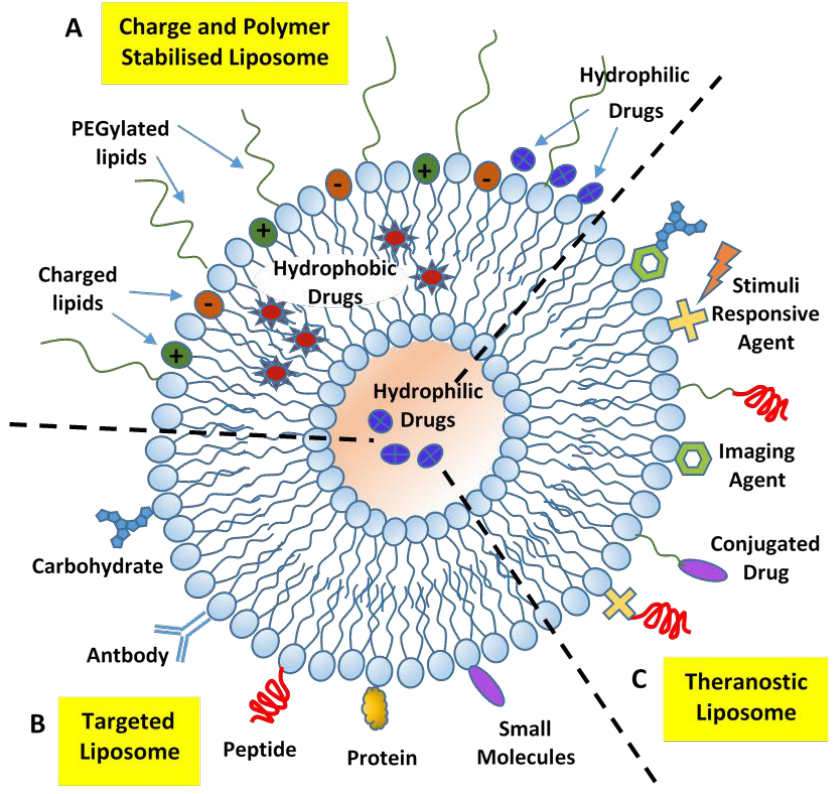
Figure 11. Schematic representation of the different types of liposomal drug delivery systems: Charge and polymer stabilized ( A ), targeted ( B ), and theranostic ( C ) liposomes.